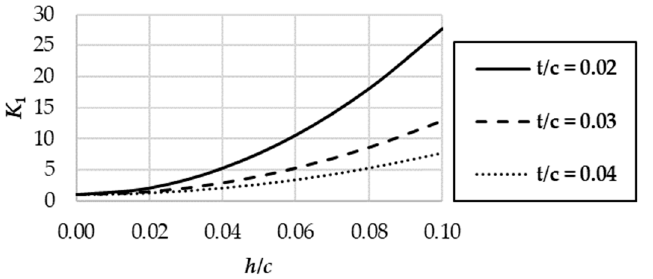
Figure 7. The value of K 1 as a function of relative camber for various relative thicknesses.